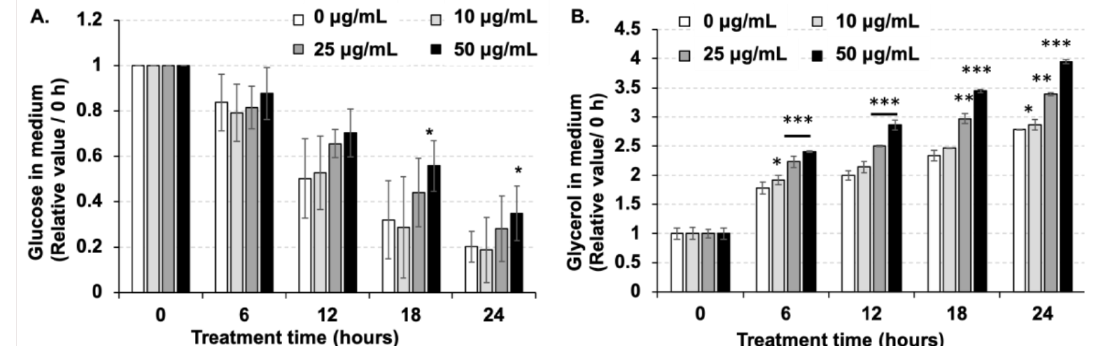
Figure 2. Effects of amber extract on lipid metabolism. After mature adipocytes were treated with amber extract (0, 10, 25, and 50 µ g/mL) for 6, 12, 18, and 24 h, the culture medium was collected. The amount of ( A ) glucose and ( B ) glycerol in the medium at 6, 12, 18, and 24 h after treatment with amber extract was measured. The decrease in glucose content in the medium compared with that at 0 h was recognized as the amount of glucose uptake. The results are indicated as the mean ± SD; n = 4; * p < 0.05, ** p < 0.01, *** p < 0.001 vs. 0 µ